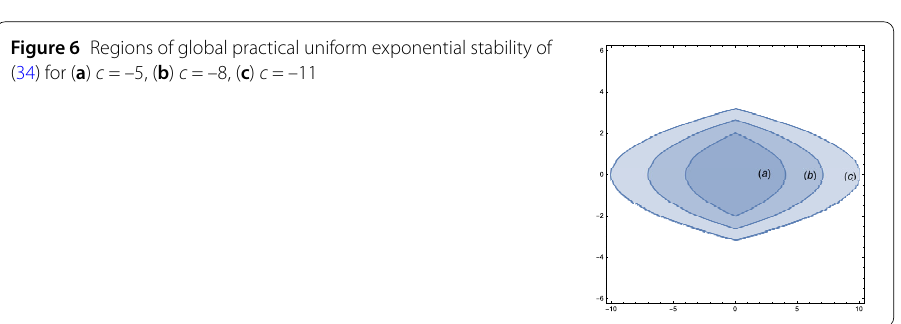
Figure 6 Regions of global practical uniform exponential stability of (34) for ( a ) c = –5, ( b ) c = –8, ( c ) c =